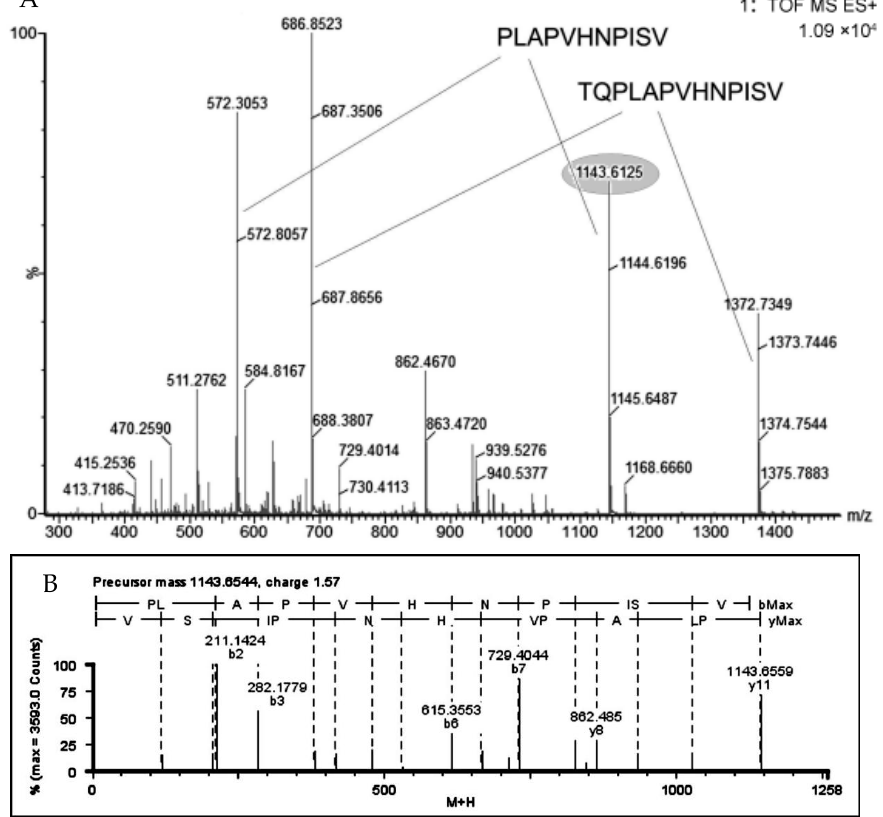
3.2. Sequencing Analysis and Quantification of LMWPs